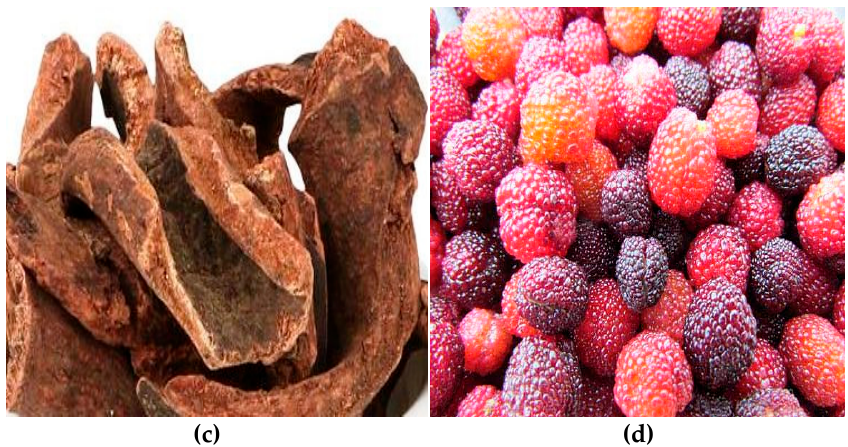
Figure 3. Myrica esculenta ( a ) Whole plant; ( b ) Leaf; ( c ) Bark; ( d ) Fruit.